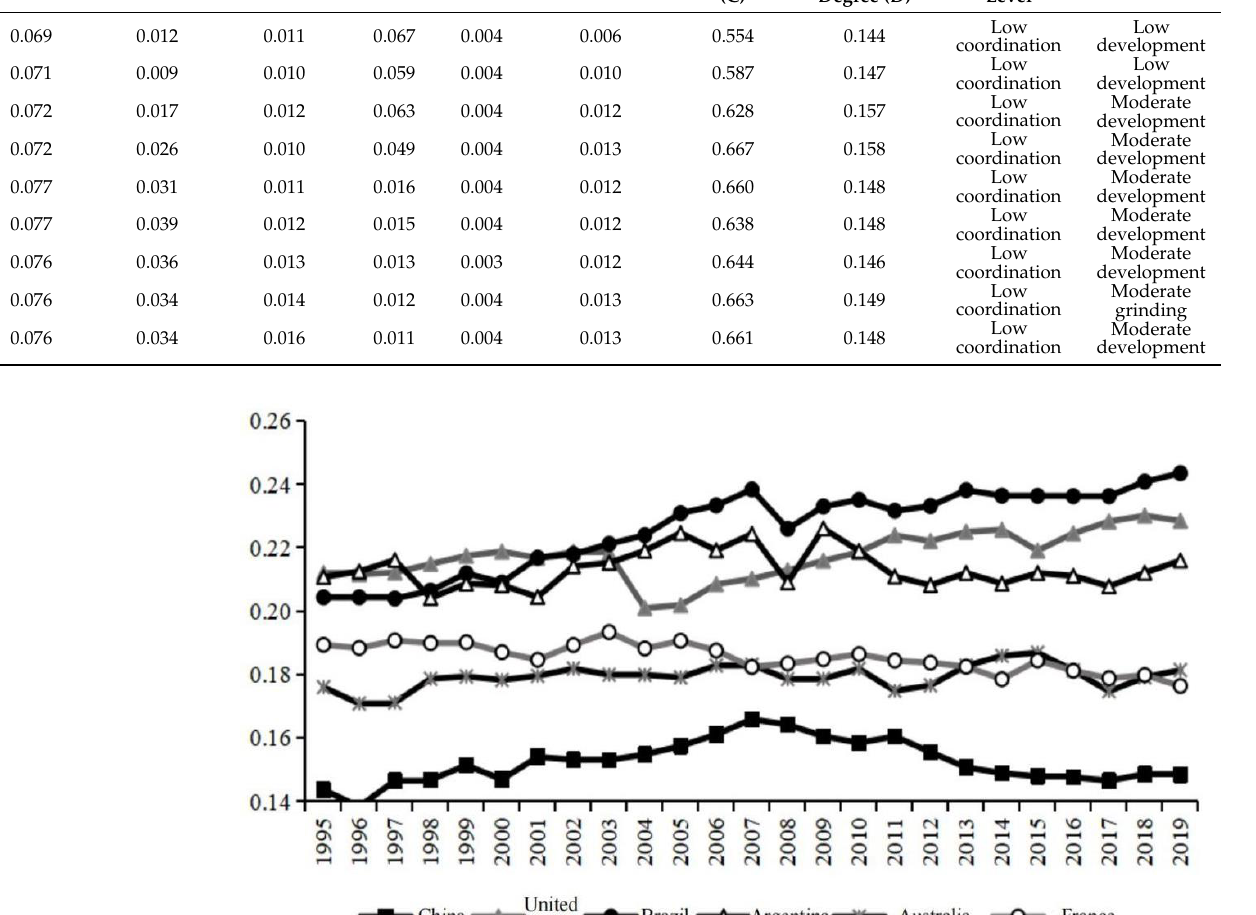
Table 5. Relative development degree of China ’ s beef cattle industry subsystems.